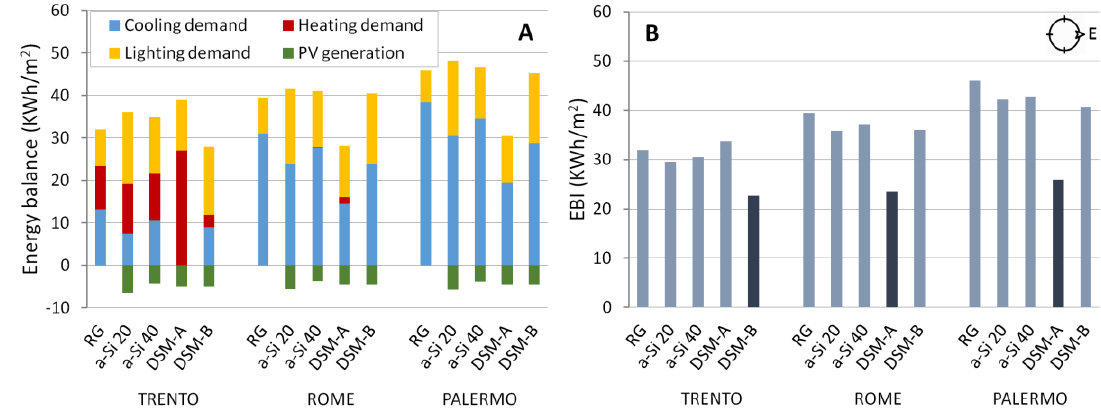
Figure 9. ( A ) Energy balance for the various STPV tested, compared to the reference glass (RG) of the STD building with an eastern orientation at the three locations; ( B ) EBI index evaluated for the same orientation and glazing